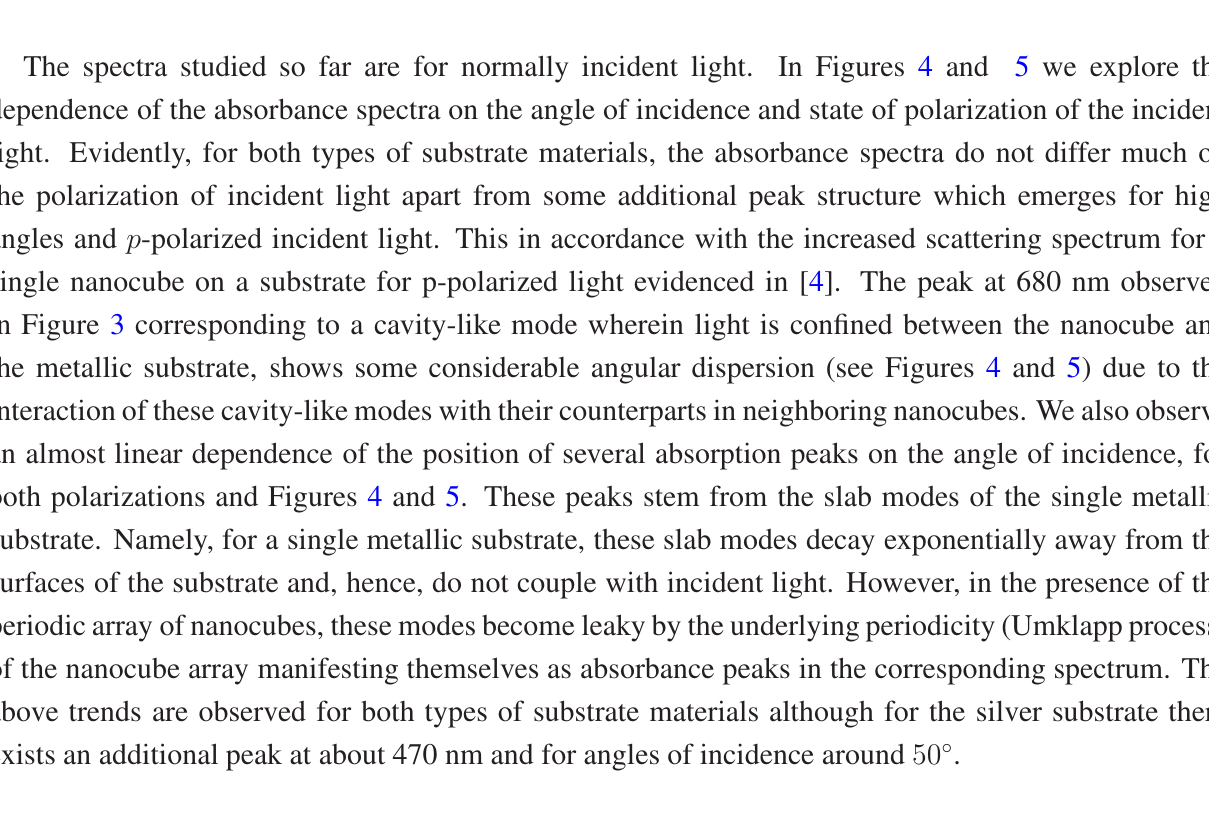
Figure 4. Absorbance vs angle of incident for s - (left panel) and p -polarized (right panel) light incident on the square array of nanocubes of Figure 2 atop an 8 nm polyelectrolyte film and 50 nm gold